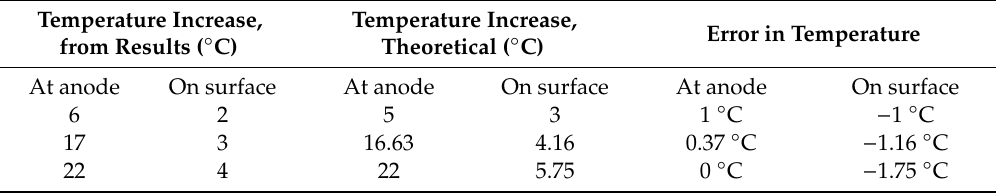
Table 6. The increase in measured temperature and its error in comparing the experimental and theoretical